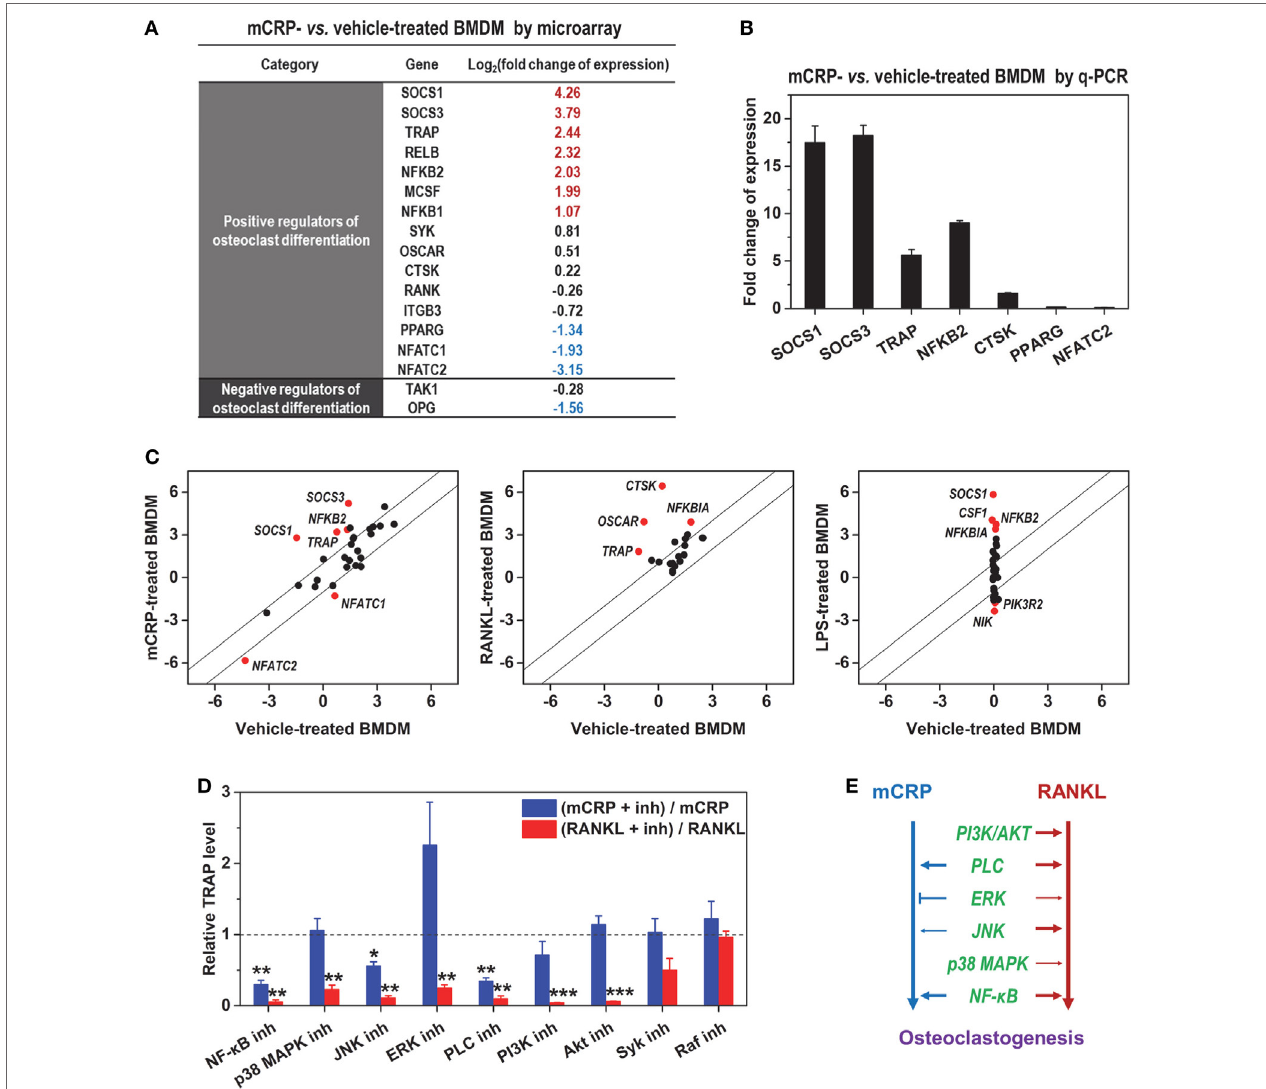
FigUre 3 | mCRP acts via receptor activator of NF- κ B ligand (RANKL)-independent pathway. (a) The expression profiles of mCRP- and vehicle-treated bone marrow-derived macrophages (BMDMs) were determined with DNA microarray. The expression changes of confidently determined genes relevant to osteoclast differentiation were listed. mCRP did not induce the expression of RANKL or its activating receptor RANK. (B) q-PCR validation of gene expression induced by mCRP. (c) Comparison of the effects of mCRP, RANKL (GSE57468), and LPS (GSE21895) on the expression of osteoclastogenesis-relevant genes. Remarkable differences in their effects were evident. (D) BMDMs were treated with mCRP or RANKL in the presence or absence of the indicated signaling inhibitors: Bay11- 7082 (10 µM, NF- κ B inh), SB20358 (20 µM, p38 MAPK inh), SP600125 (10 µM, JNK inh), U0126 (10 µM, ERK inh), U73122 (10 µM, Phospholipase C (PLC) inh), LY294002 (50 µM, PI3K inh), MK-2206 2HCl (5 µM, Akt inh), Piceatannol (10 µM, Syk inh), and GW5074 (20 µM, Raf inh). The mRNA levels of TRAP were determined by q-PCR and normalized to that of controls treated only with inhibitor. Results are shown as (TRAP level of cells treated with mCRP or RANKL plus the indicated inhibitor)/(TRAP level of cells treated with mCRP or RANKL). (e) The signaling pathways evoked by the two inducers differed